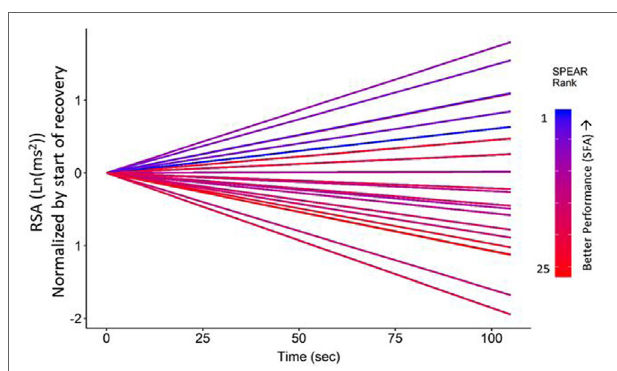
FigUre 5 | Respiratory sinus arrhythmia (RSA) time trends by Soldier Performance and Effective, Adaptable Response (SPEAR) security force assistance (SFA) ranked score. Recovery of RSA during final recovery baseline prior to the SPEAR task was correlated with greater scores on the SFA block of trials, ρ (20) = 0.58, p < 0.01. SPEAR performance ranked scores are color-coded on a gradient scale ranging from cool, blue colors (highest scores) to reds (low scores). Highest scores were observed in participants who showed increasing RSA across the 2-min recovery period just prior to the SPEAR